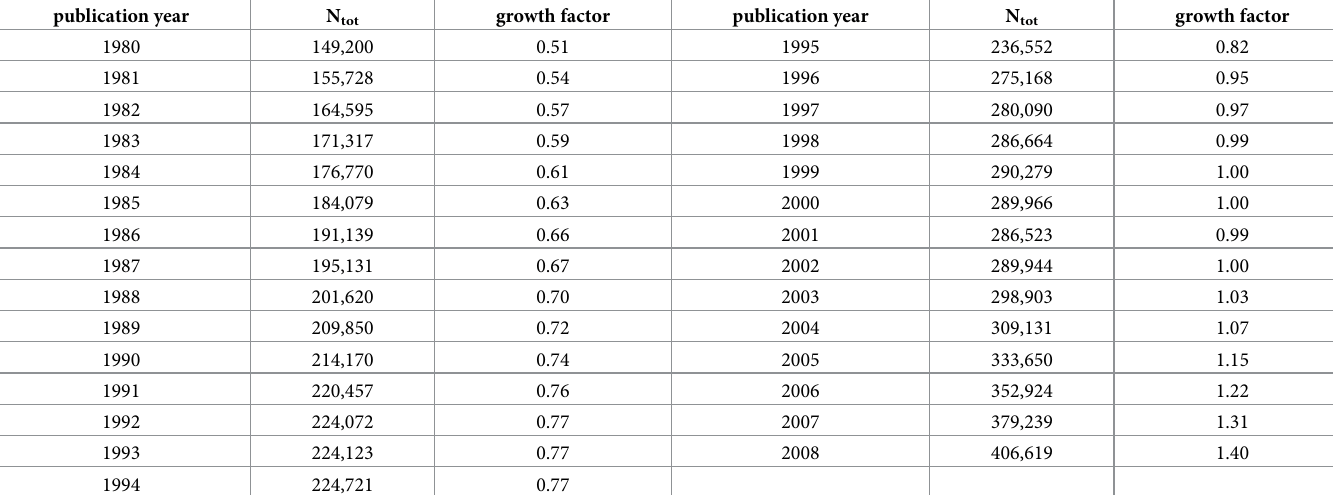
Table 2. Number of WoS-covered publications in the medical research fields.